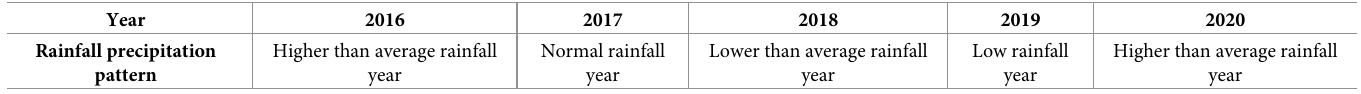
Table 4. Annual rainfall precipitation pattern from 2016 to 2020.